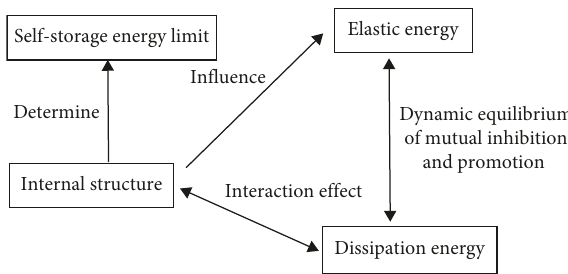
Figure 5: Interaction between internal structure and